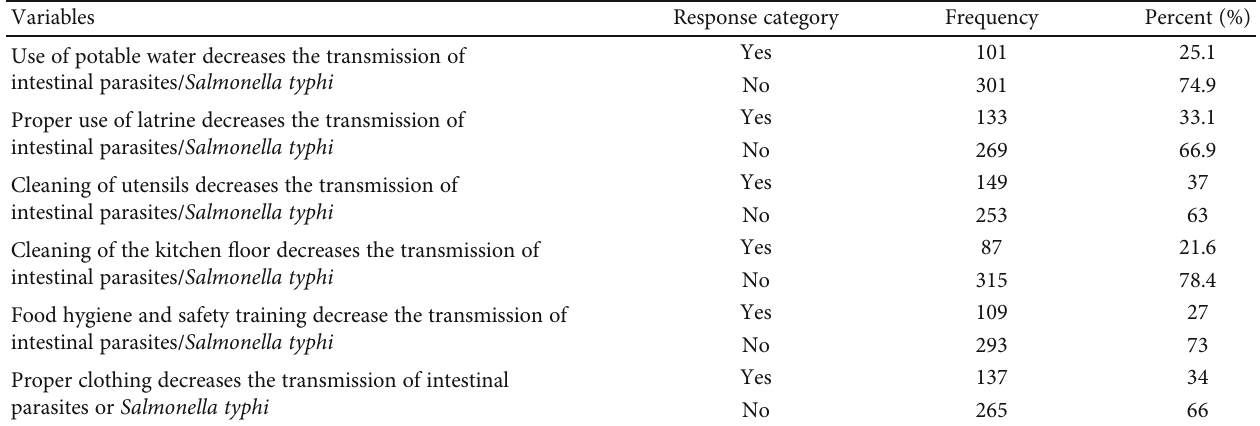
Table 4: Knowledge-related factors of food handlers working in catering establishments in Dawuro Zone, South-Western Ethiopia, March to July 2019 ( N = 402